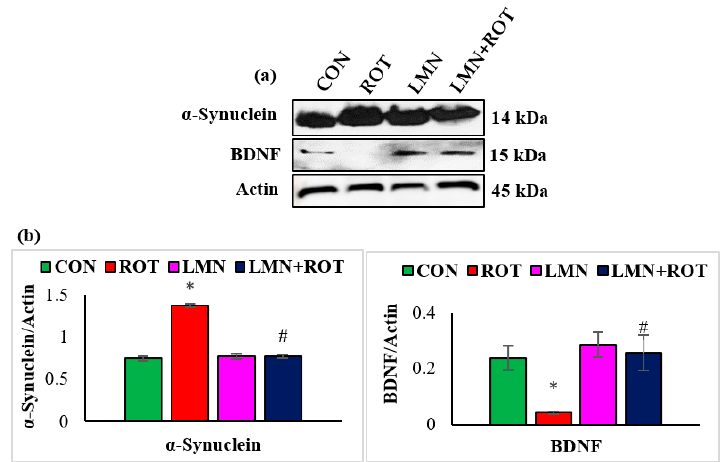
Figure 3. Representative images of Western blots and densitometric analysis for BDNF and α -synuclein expressions in the striatal tissues ( a , b ). Immunoblotting was performed in duplicates and the data are expressed as the mean ± SEM. * p < 0.05 CON vs. ROT; # p < 0.05 ROT vs. LMN + ROT (one- way ANOVA followed by DMRT). CON: normal control, ROT: rotenone, LMN: limonene, LMN + ROT: limonene and rotenone treatment.